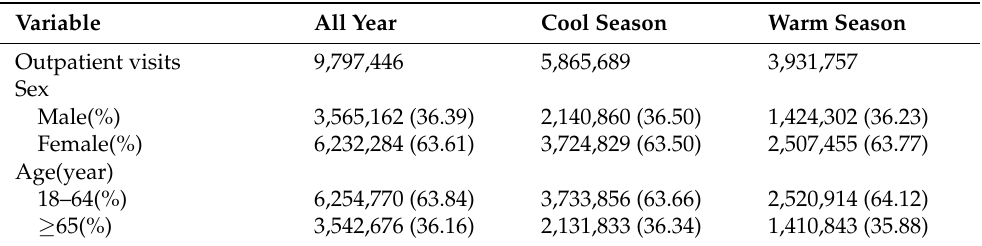
Table 1. Data on outpatient visits for knee osteoarthritis between 1 January 2010, and 31 December 2017, in Beijing,